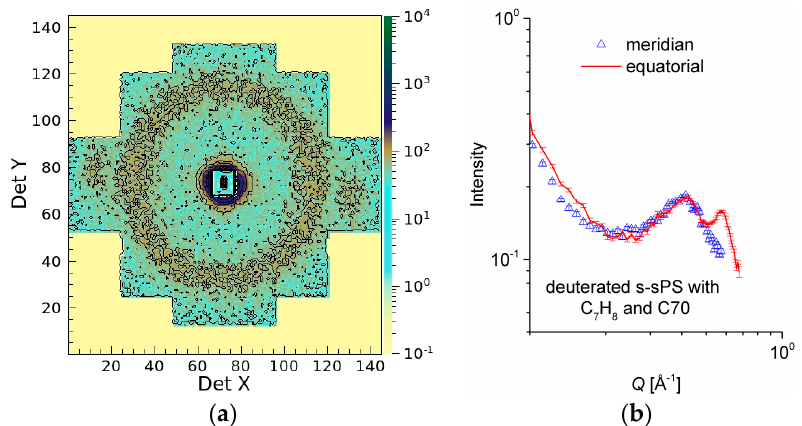
Figure 5. Two-dimensional SANS pattern from a dry s-sPS film containing the co-crystalline δ -phase with protonated toluene and loaded with C70 fullerenes ( a ) and one-dimensional scattering profiles from the same sample averaged over the equatorial (line) or meridian (symbol) directions, respectively ( b ). All data were collected at L D = 2 m.